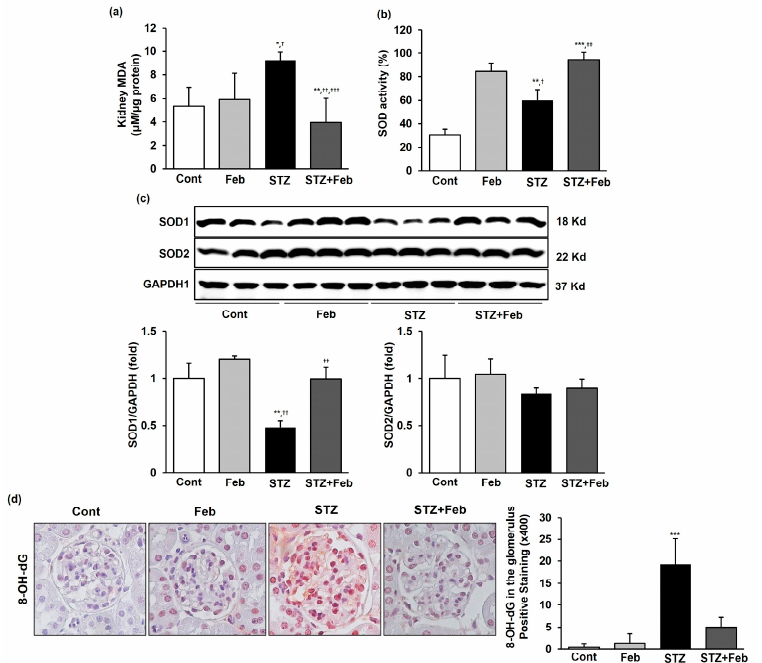
Figure 6. The effects of febuxostat on intrarenal MDA, SOD activity, and immunohistochemical staining for 8-OH-dG in STZ-induced diabetic mice. ( a ) Concentrations of the lipid peroxidation marker MDA in mouse kidneys. * p < 0.05 and ** p < 0.01 vs. Cont, † p < 0.05 and †† p < 0.01 vs. Feb, and ‡‡‡ p < 0.001 vs. STZ group. ( b ) SOD activity in mouse kidneys. ** p < 0.01 and *** p < 0.001 vs. Cont, † p < 0.05 vs. Feb, and ‡‡ p < 0.01 vs. STZ group. ( c ) Representative images and quantitative analyses for SOD1/GAPDH and SOD2/GAPDH, ** p < 0.01 vs. Cont, †† p < 0.01 vs. Feb and ‡‡ p < 0.01 vs. STZ group. ( d ) Representative immunohistochemical staining and semiquantitative analysis for 8-OH-dG in mouse kidneys (original magnification 400 × ). *** p < 0.001 vs. other